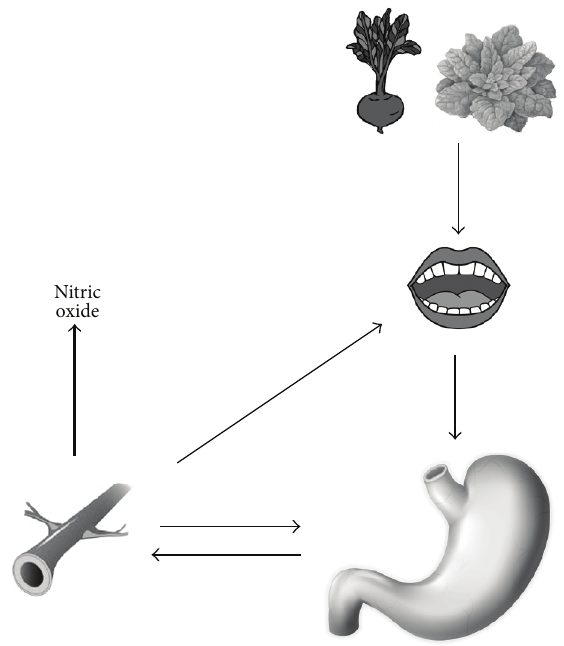
Figure 1: Nitrate (thin arrows) intake from the diet is swallowed and completely absorbed in the upper gastrointestinal tract. About 25% of this amount is concentrated in the salivary glands and still inside the mouth is reduced to nitrite by anaerobic bacteria present on the tongue and is swallowed again. In the stomach, nitrite acid undergoes reduction and is converted to NO (thick arrows) that has vasodilatory action on blood